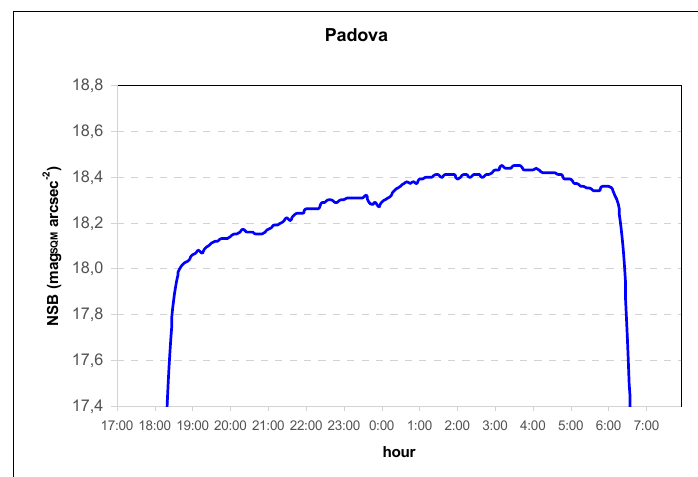
Figure 7. NSB at Padova by SQM for the night 2019/04/02–2019/05/02.